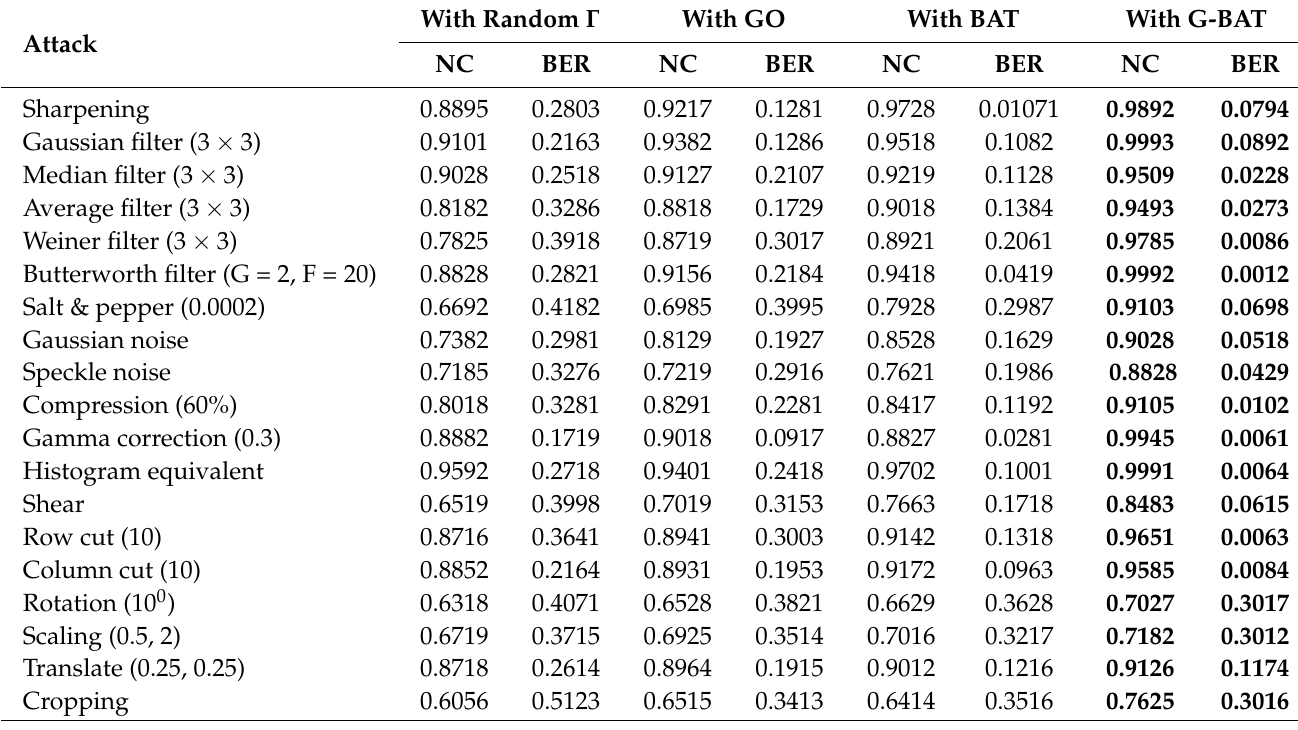
Table 5. NC and BER for aerial RS images Img3 (taken from USC-SIPI [29]) under attacks with random Γ and with optimized Γ using GO, BAT and